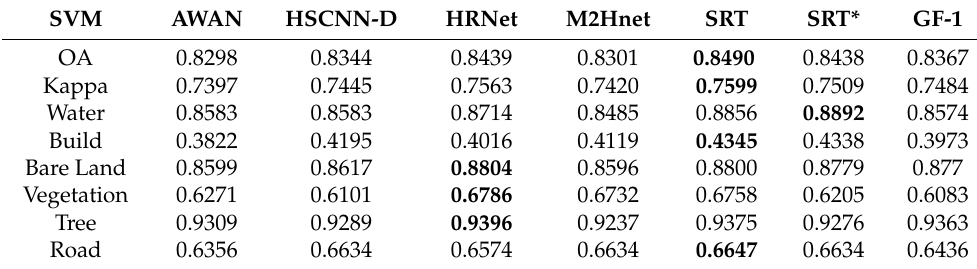
Table 10. Accuracy of classification result of Area3 with SAM. The best results are shown in